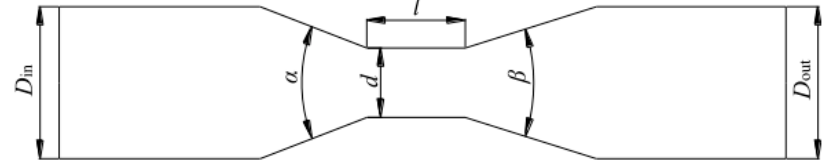
Figure 1. Structural diagram of Venturi tube.